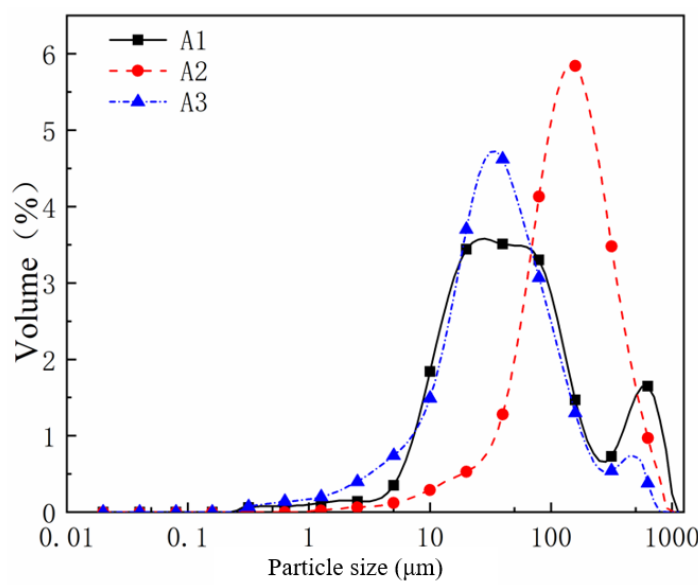
Figure 9. Particle size distribution of fly ash.